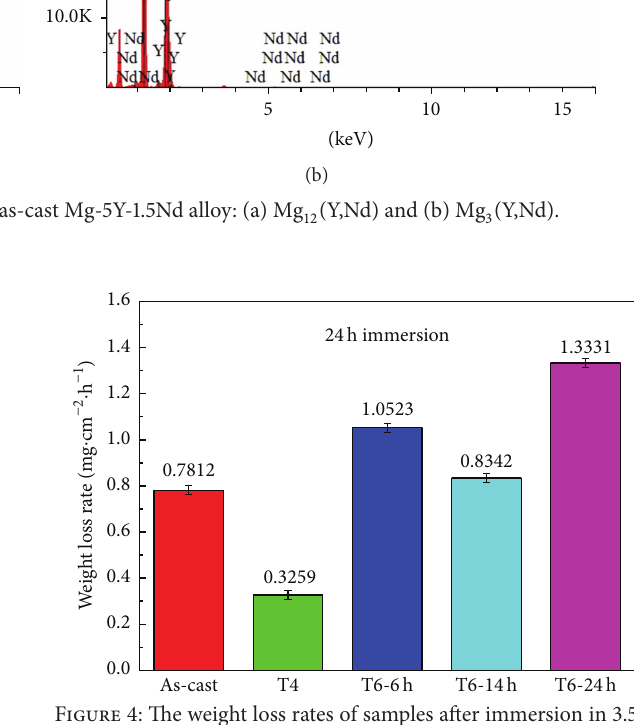
Figure 4: The weight loss rates of samples after immersion in 3.5% NaCl for 24 hours.